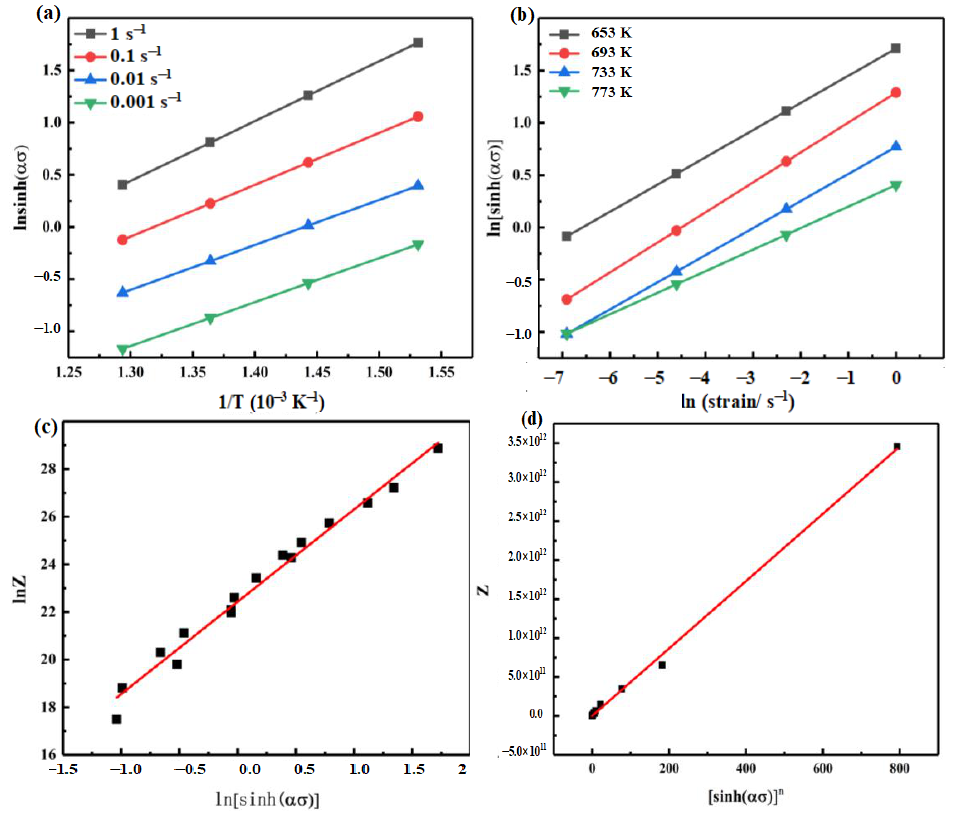
Figure 3. Fitting curve images in the calculation of the constitutive equation. ( a ) ln [ sinh ( ασ )] − 1/T 10 − 3 K − 1 ; ( b ) ln [ sinh ( ασ )] − ln strain/s − 1 ; ( c ) lnZ − ln [ sinh ( ασ )] n ; ( d ) Z − [ sinh ( ασ )] n